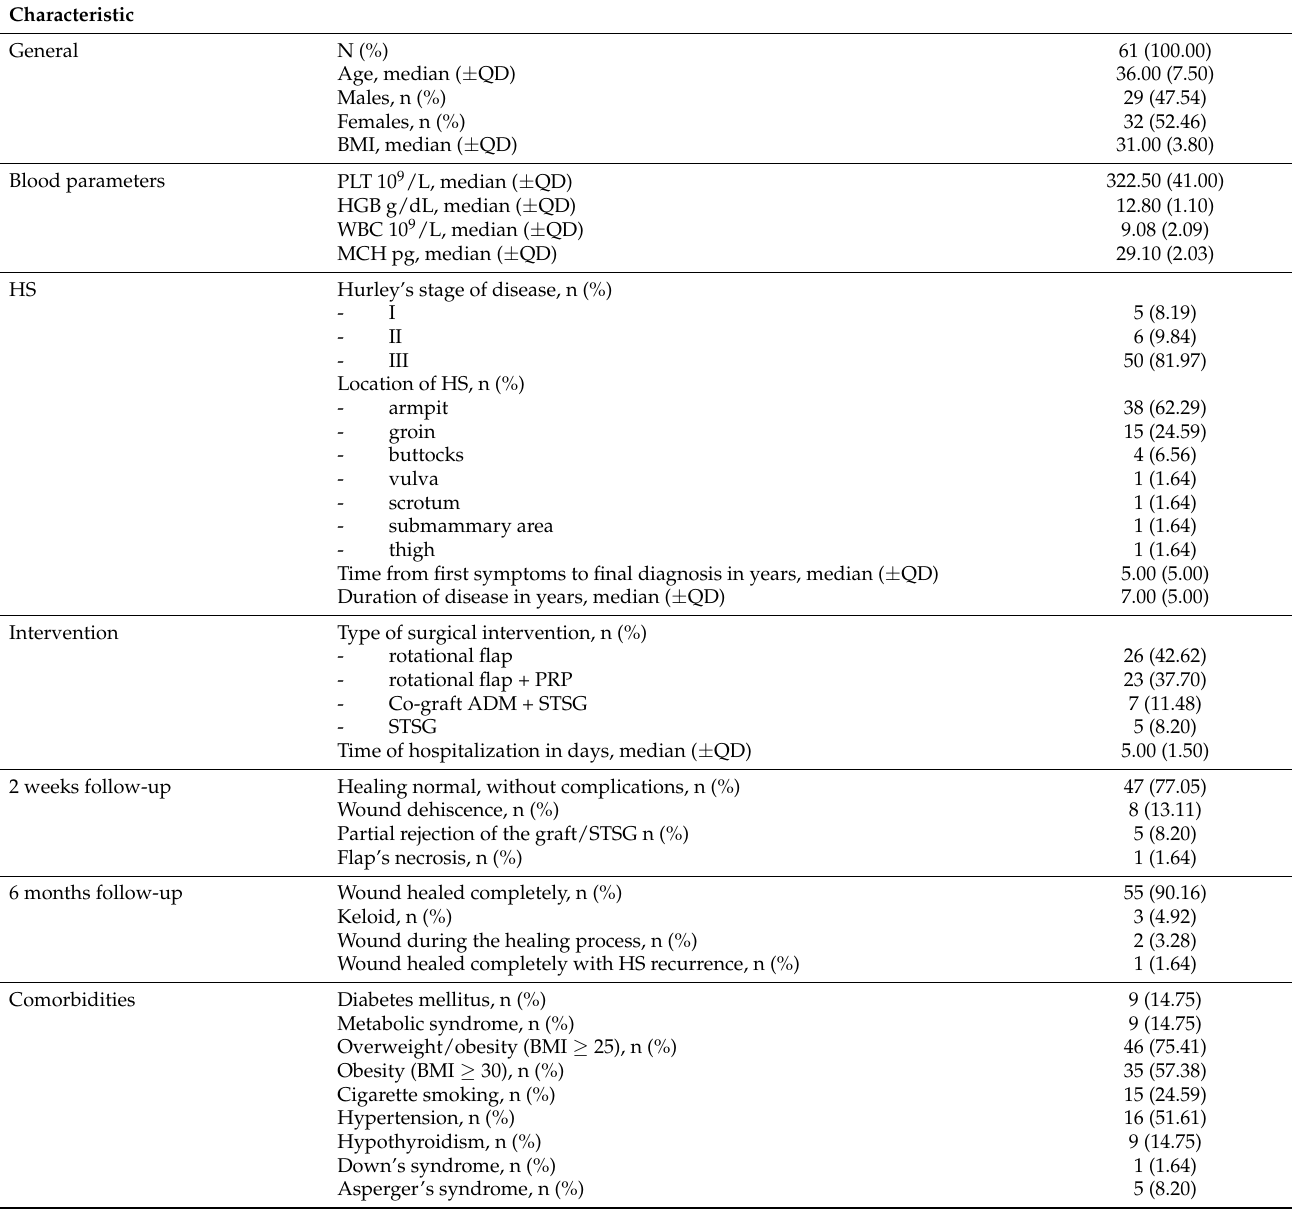
Table 1. General and clinical characteristics of the study